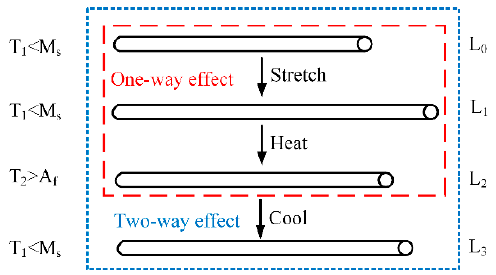
Figure 5. Two-way shape memory